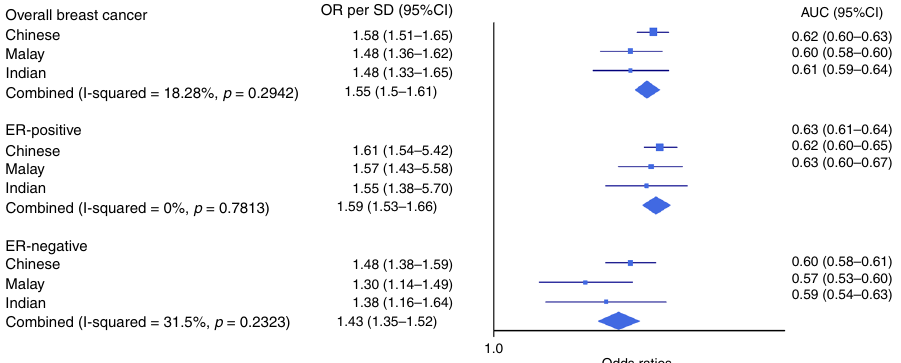
Fig. 3 Association between standardised PRSs and breast cancer risk in Chinese, Malay and Indian women from Malaysia and Singapore. Odds ratios (ORs) and AUCs were generated using data from Malaysia Breast Cancer Genetics (MyBrCa) and Singapore Breast Cancer Cohort (SGBCC) studies, strati fi ed by ethnicity. The squares represent the odds ratios (ORs), the horizontal lines represent the corresponding 95% con fi dence intervals and the diamond shapes represent the overall estimates. I-squared and p value (two-sided) for heterogeneity were obtained by fi tting a random-effects model and using generalised Q -statistic estimator (the rma() command in R). The number of cases and controls for each ethnicity by breast cancer subtypes are tabulated in Table 4. The sample size, ORs and corresponding 95% con fi dence intervals are also provided in the Source Data fi le.